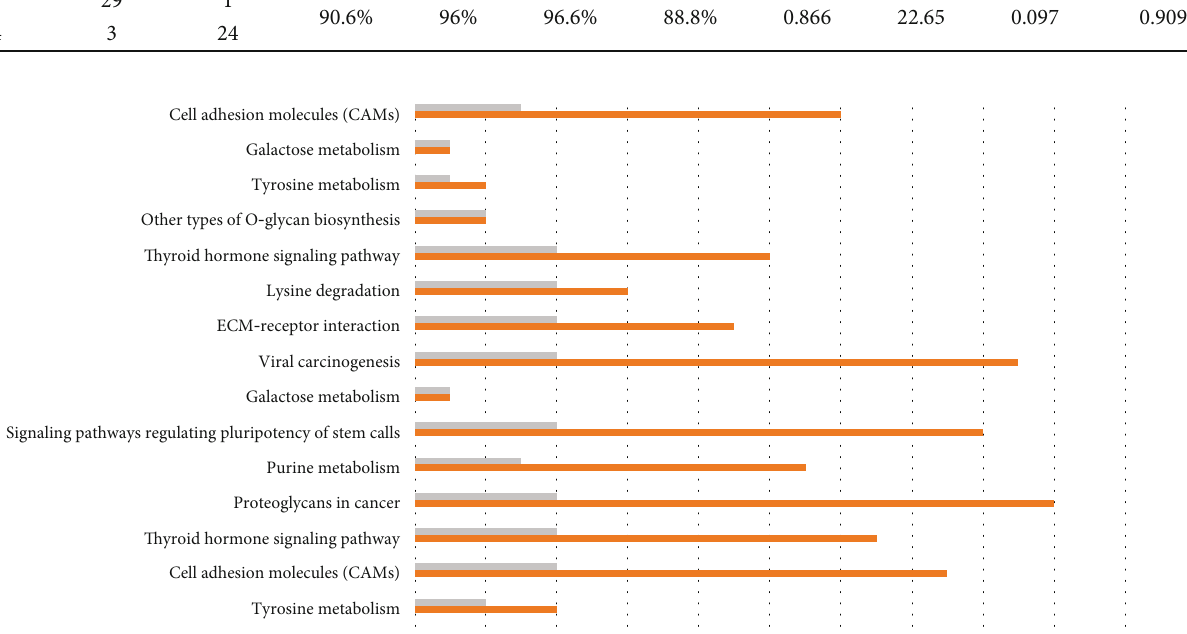
Table 7: Clinical characteristics of the 57 chronic hepatitis B patients for miRNA chip analysis ( (cid:1) x ± s ). Group